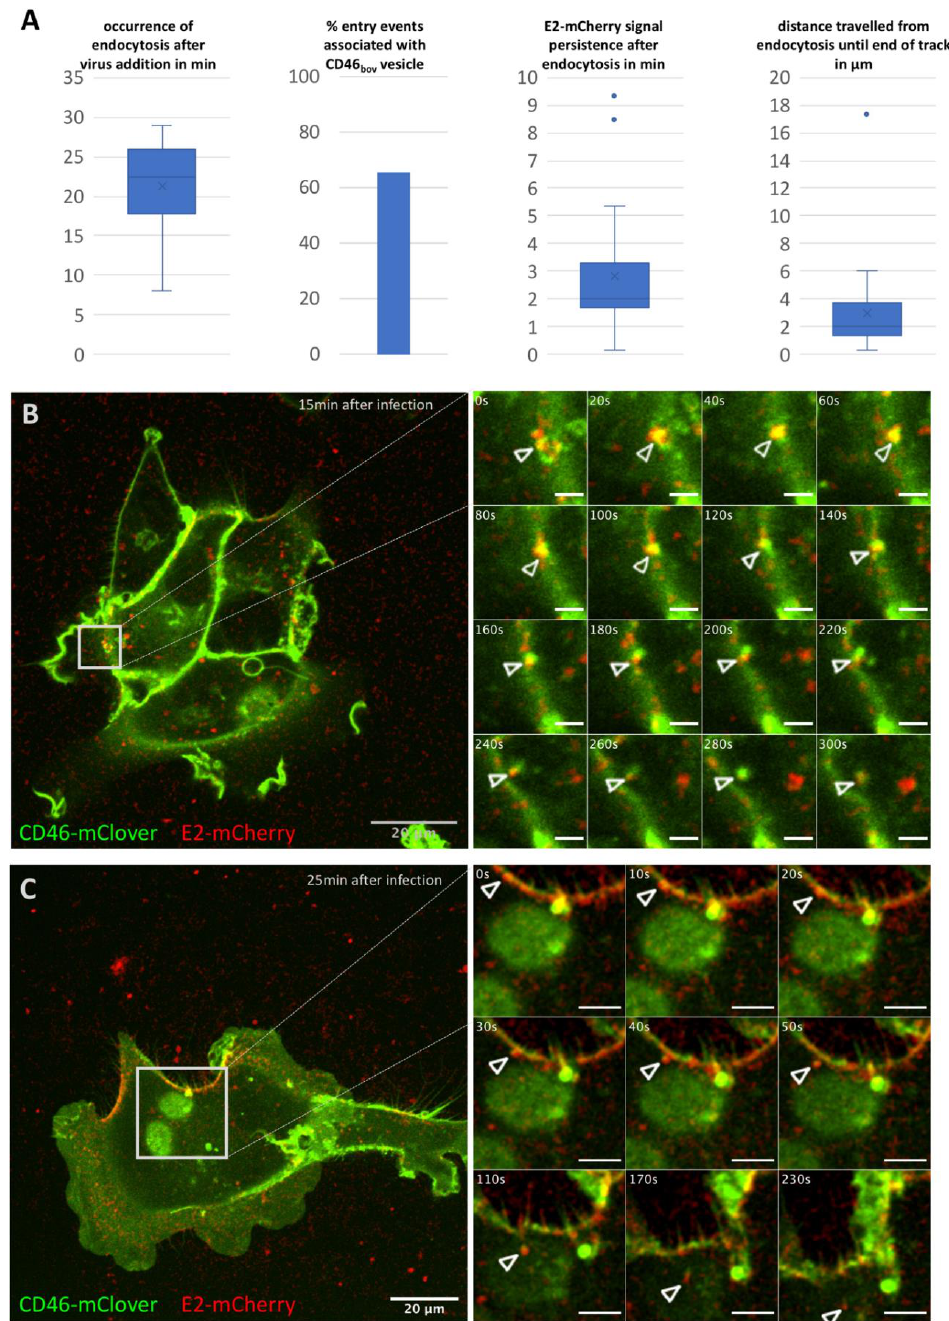
Figure 1. Characterization of BVDV E2-mCherry entry into SK6 CD46 fluo cells. ( A ) Characterization of 26 entry events of BVDV E2-mCherry in SK6 CD46 fluo cells with regard to occurrence after virus addition, association with CD46 fluo signal, intracellular persistence of the E2-mCherry signal and intracellular distance travelled. Outliers (Q3 + 1.5-times interquartile range) are indicated by dots. ( B , C ) Examples of entry events of BVDV E2-mCherry (red) into SK6 CD46 bov (green) cells. The full field of view at the time of the start of acquisition (time after virus addition is specified in the top right corner) is shown and the area of interest is indicated by grey squares. Frames as depicted in the detail images were acquired every 10 s for up to 10 min after the start of acquisition. Times indicated in s refer to the start of acquisition. The length of the scale bar in the detail images in ( B ) = 2.5 µm and in ( C ) = 5 µm.